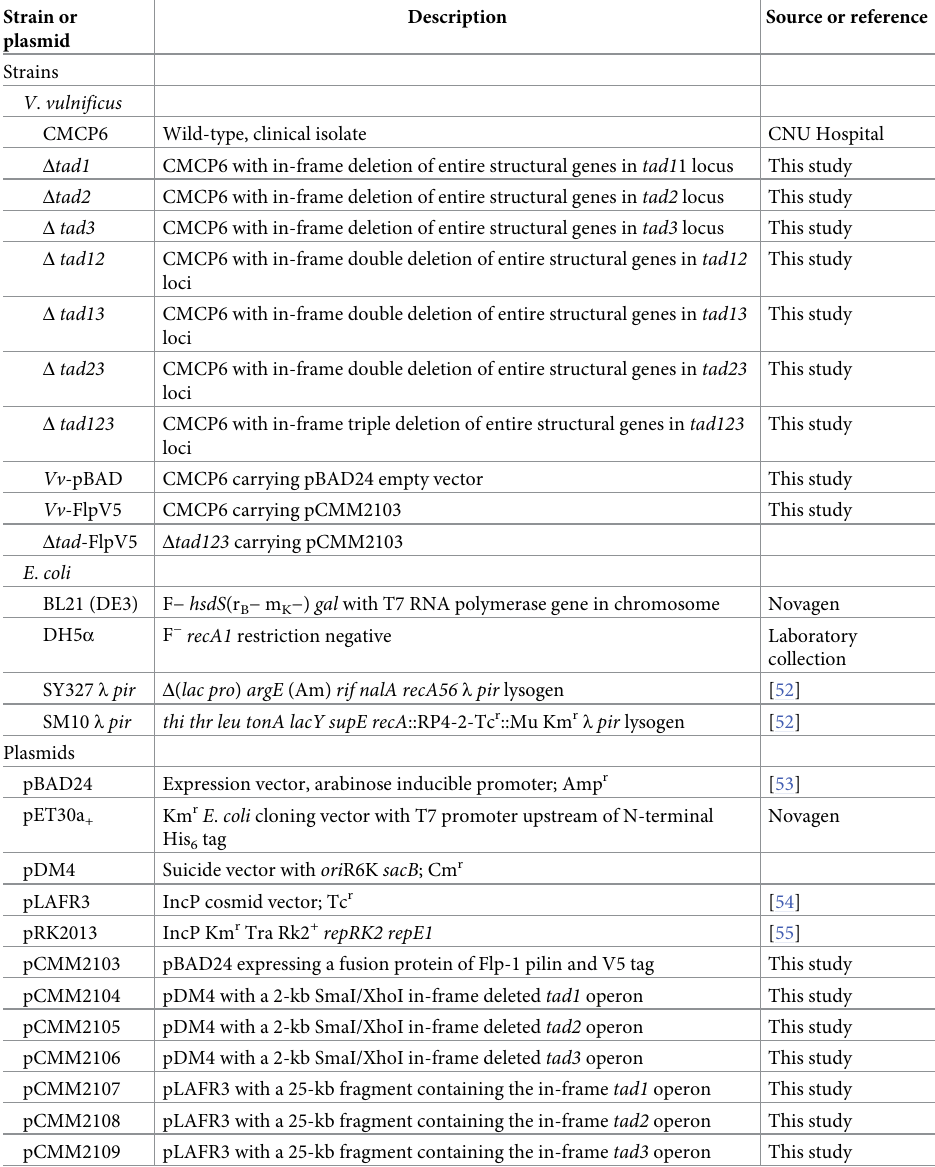
Table 2. Strains and plasmids used in this study.